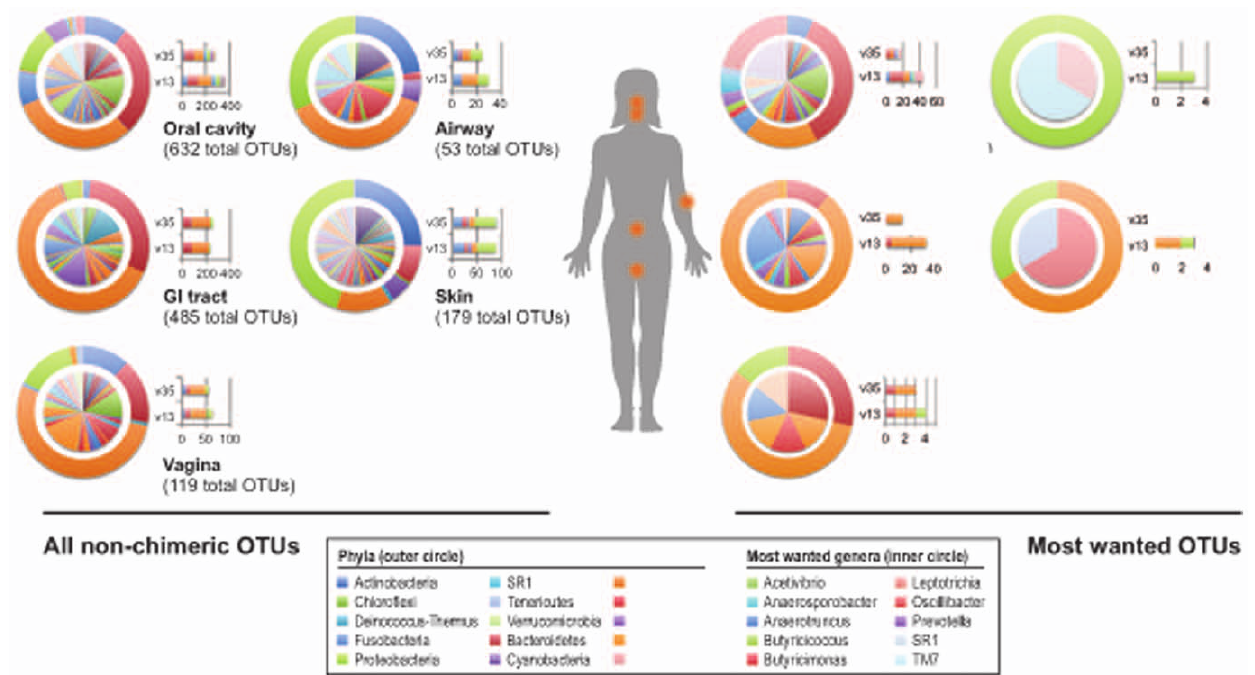
Figure 2. Body habitat distribution of non-chimeric and most wanted HMP OTUs. The distributions of 1,468 non-chimeric HMP OTUs (left panel) and 119 most wanted OTUs (right panel) are shown as phyla (outer circle) and genera (inner circle) at each of the 5 sampled body habitats. Distribution profiles were based on the habitat in which the HMP OTU was found most frequently. Bar graphs illustrate the relative proportion of HMP OTUs from each 16S variable region, shown as phyla. Color codes for all phyla and ‘most wanted’ genera with more than one representative are shown in left and right figure legends, respectively.